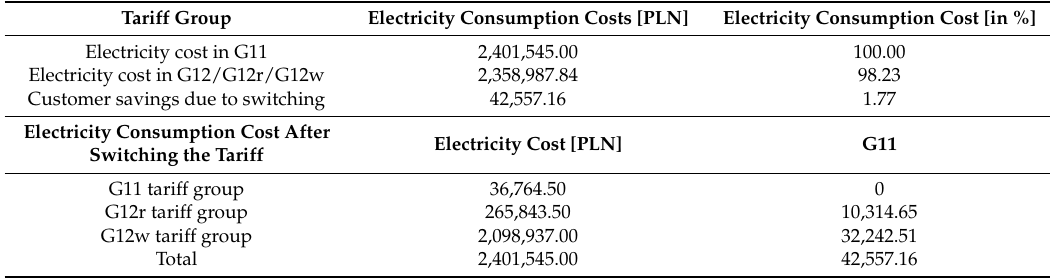
Table 1. Simulation of households electricity consumption cost based on different tariff group rates.